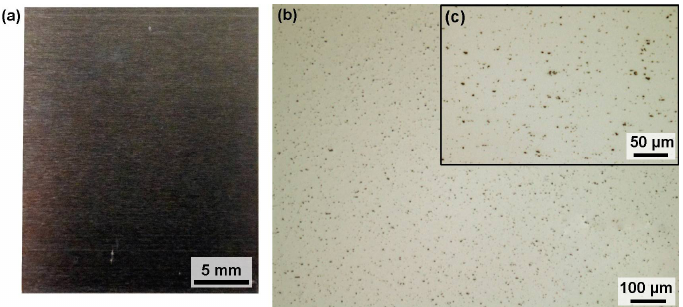
Figure 1. ( a ) Experimental sample and ( b ) representation of its microstructure, and ( c ) detail of